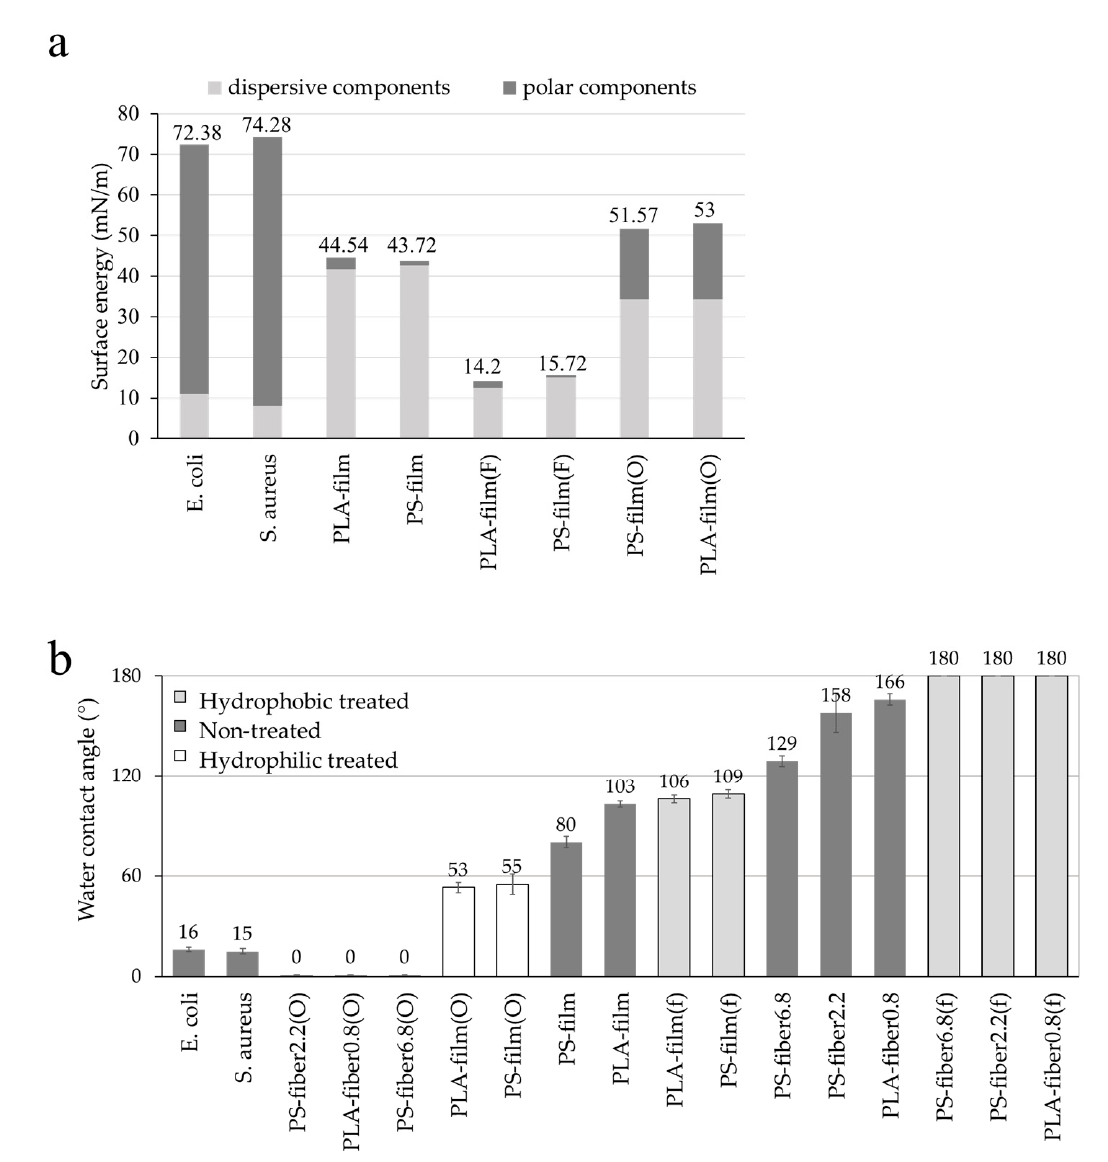
Figure 1. Surface energy and wettability. ( a ) Surface energy with polar and dispersive components; ( b ) water contact angle of different surfaces.